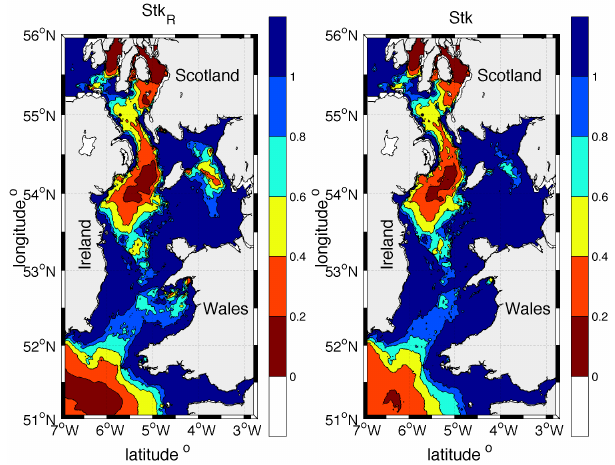
Fig. 7. Rotational (a) and non-rotational (b) Stokes number for the Irish Sea.